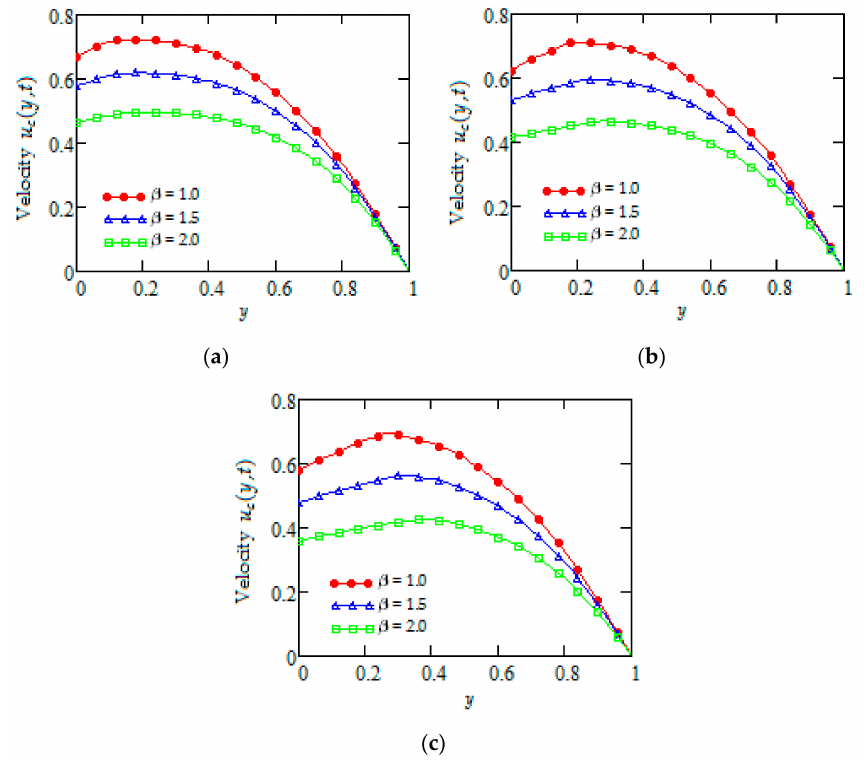
Figure 2. The profiles of velocity u c ( y , t ) for We = 0.75 and different values of the pressure–viscosity